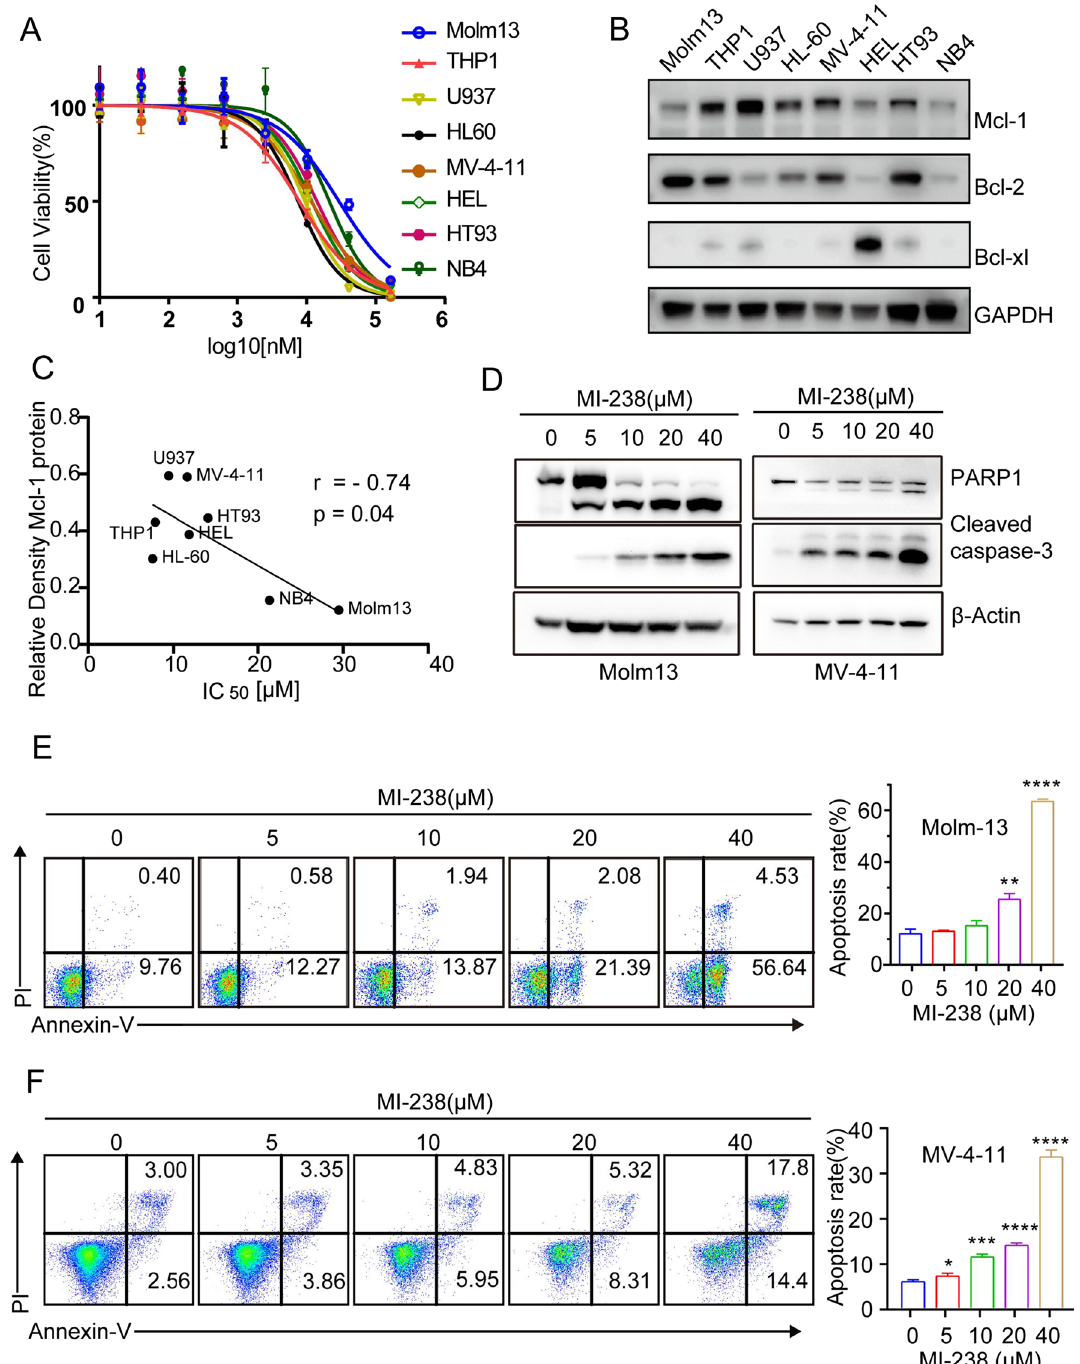
Fig. 3 MI-238 effectively induces apoptosis in AML cells. A The cell viability of indicated 8 AML cell lines in presence of increasing concentrations of MI-238 were analyzed by cell counting kit-8 (CCK8) assay and the half-maximal inhibitory concentration (IC 50 ) IC 50 were determined. B Western blot analysis of the expression of Mcl-1, Bcl-2 and Bcl-xL in AML cell lines. C Correlation of Mcl-1 protein level and the IC 50 of MI-238 were determined. D , E , F Molm13 and MV-4-11 cells were treated with increasing concentrations of MI-238 for 48 h, and the cell apoptosis was analyzed by western blot analysis of PARP1 and caspase 3 cleavage ( D ) and flow cytometry of annexin V staining ( E , F ). Data are represented as mean independent replicates, * P < 0.05, ** P < 0.01, *** P < 0.001, **** P < 0.0001 by two-tailed